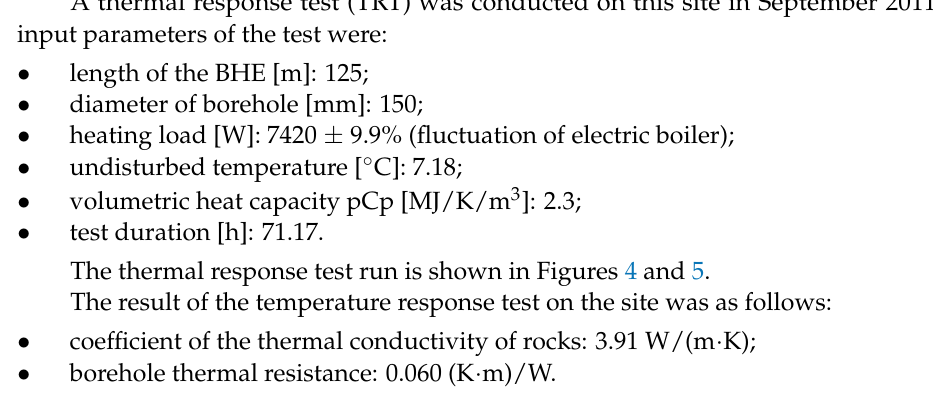
Figure 3. Average temperatures at Lysá hora in 2018 [13].